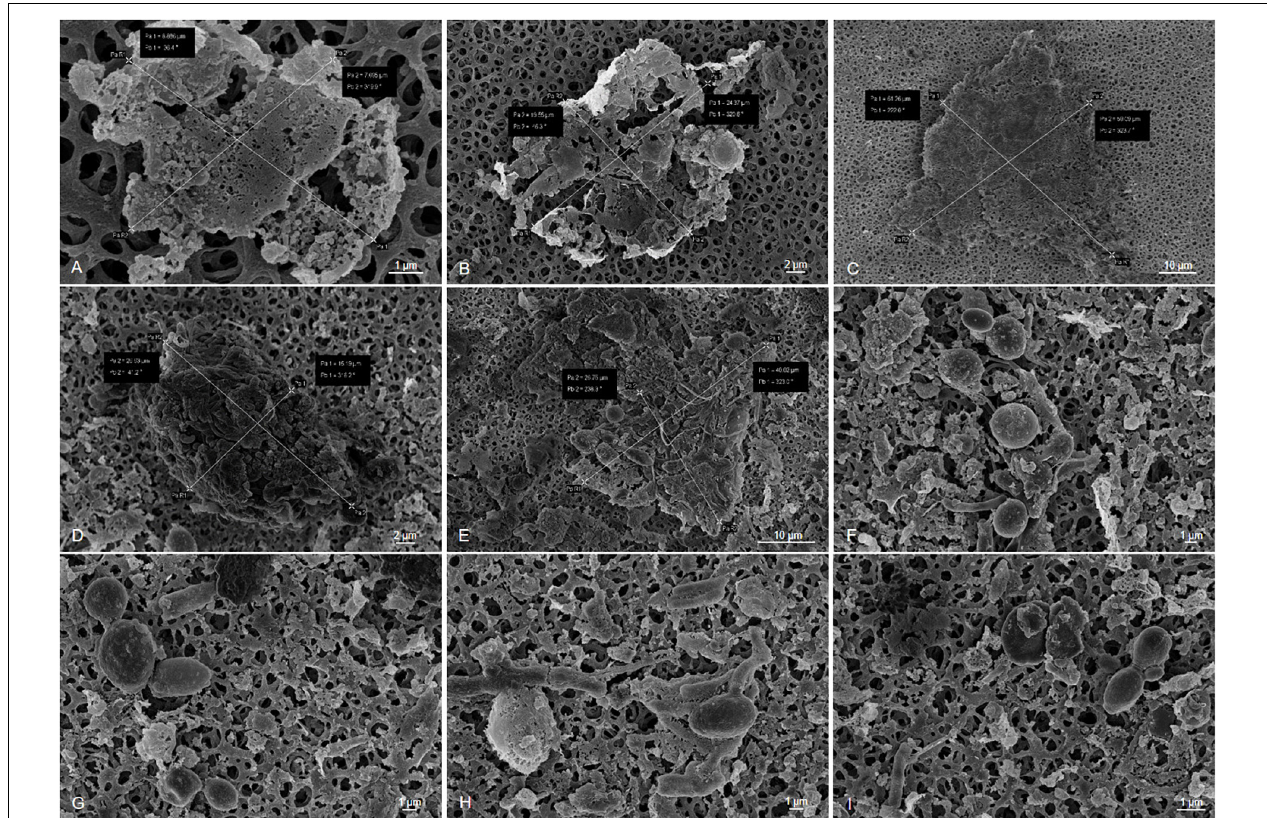
FIGURE 2 | Sonification experiments of filtered kerosene on cellulose acetate membranes (F and W sampling). Sonification conditions: amplitude 60% of 200 W, cycle: 50%, volume: 500 ml, (A–C) sonification time: 0 s, (D–F) Sonification time: 15 s, (G–I) sonification time: 30 s. Scale bars of 1–10 µ m are indicated in the images (REM LEO 1525, 5.00